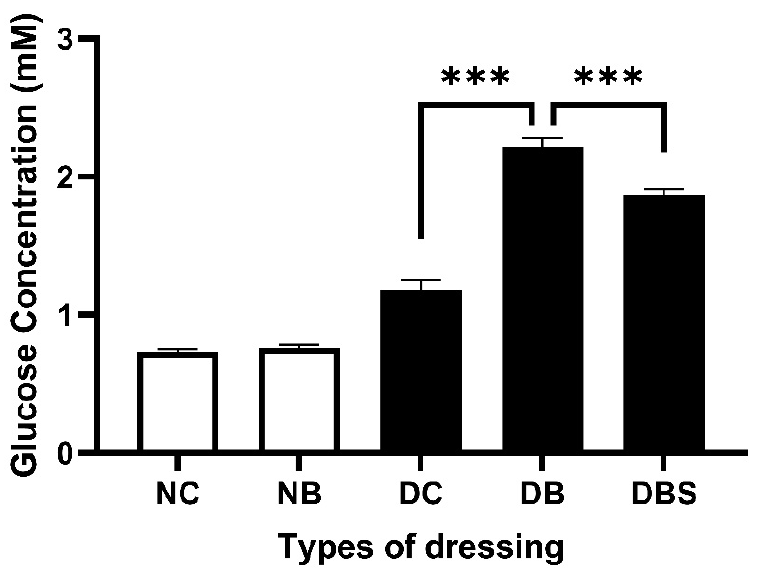
Figure 7. Glucose absorption capacities of different dressings on the wound surface of mice. NC represents wounds of C57BL/6JNarl mice ( n = 9) dressed with gauze, NB represents wounds of C57BL/6JNarl mice ( n = 9) dressed with bacterial cellulose, DC represents wounds of diabetic mice ( n = 9) dressed with gauze, DB represents wounds of diabetic mice ( n = 9) dressed with bacterial cellulose, DBS represents wounds of diabetic mice ( n = 9) dressed with a combination of bacterial cellulose and Suile ointment. The glucose contents of the dressings were measured on days 0, 1, 4, 7, 10, 14, 17, and 21 after the above treatments, and the results are presented as the average glucose contents on the above days. Bars, means of triplicates ± S.D. (***) p < 0.001, as compared with the relative control group by two-way